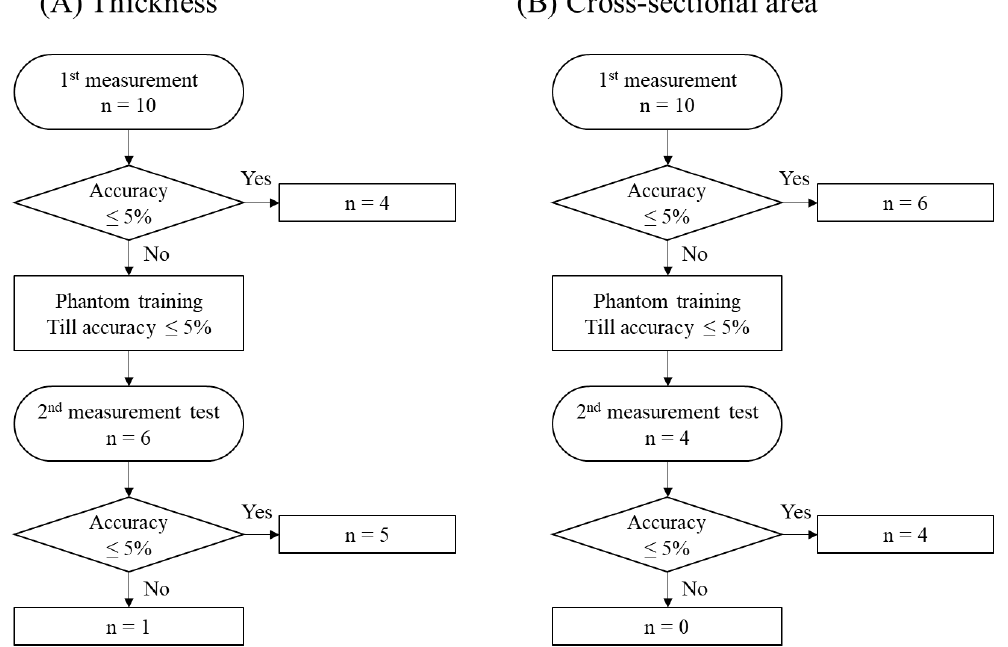
Figure 4. Measurement accuracy in a human volunteer (Study 2-2). ( A ) Thickness. ( B ) Cross-sectional area. Three months after the phantom training, around half of the examiners obtained the measurement accuracy within 5%. After the 2nd phantom training to obtain the measurement accuracy within 5%, almost all examiners obtained the measurement accuracy within